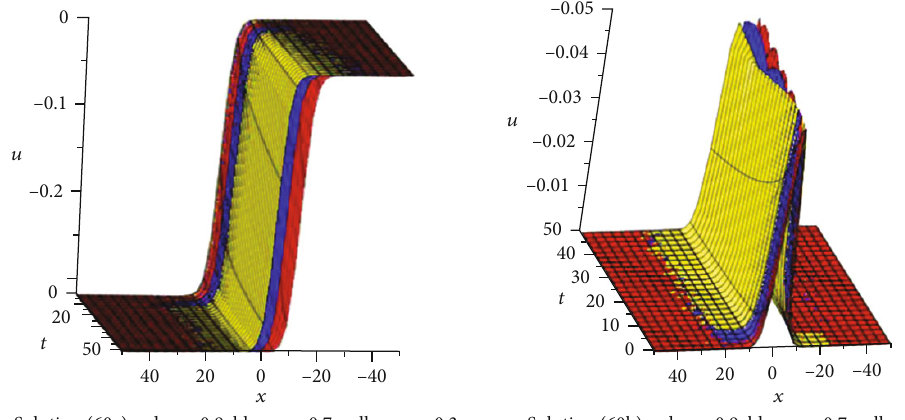
ffiffiffiffiffiffiffiffiffiffiffiffiffiffiffiffi p ffiffiffiffi p λ 2 − 4 μ , λ − 2, μ = 0 : 4 .